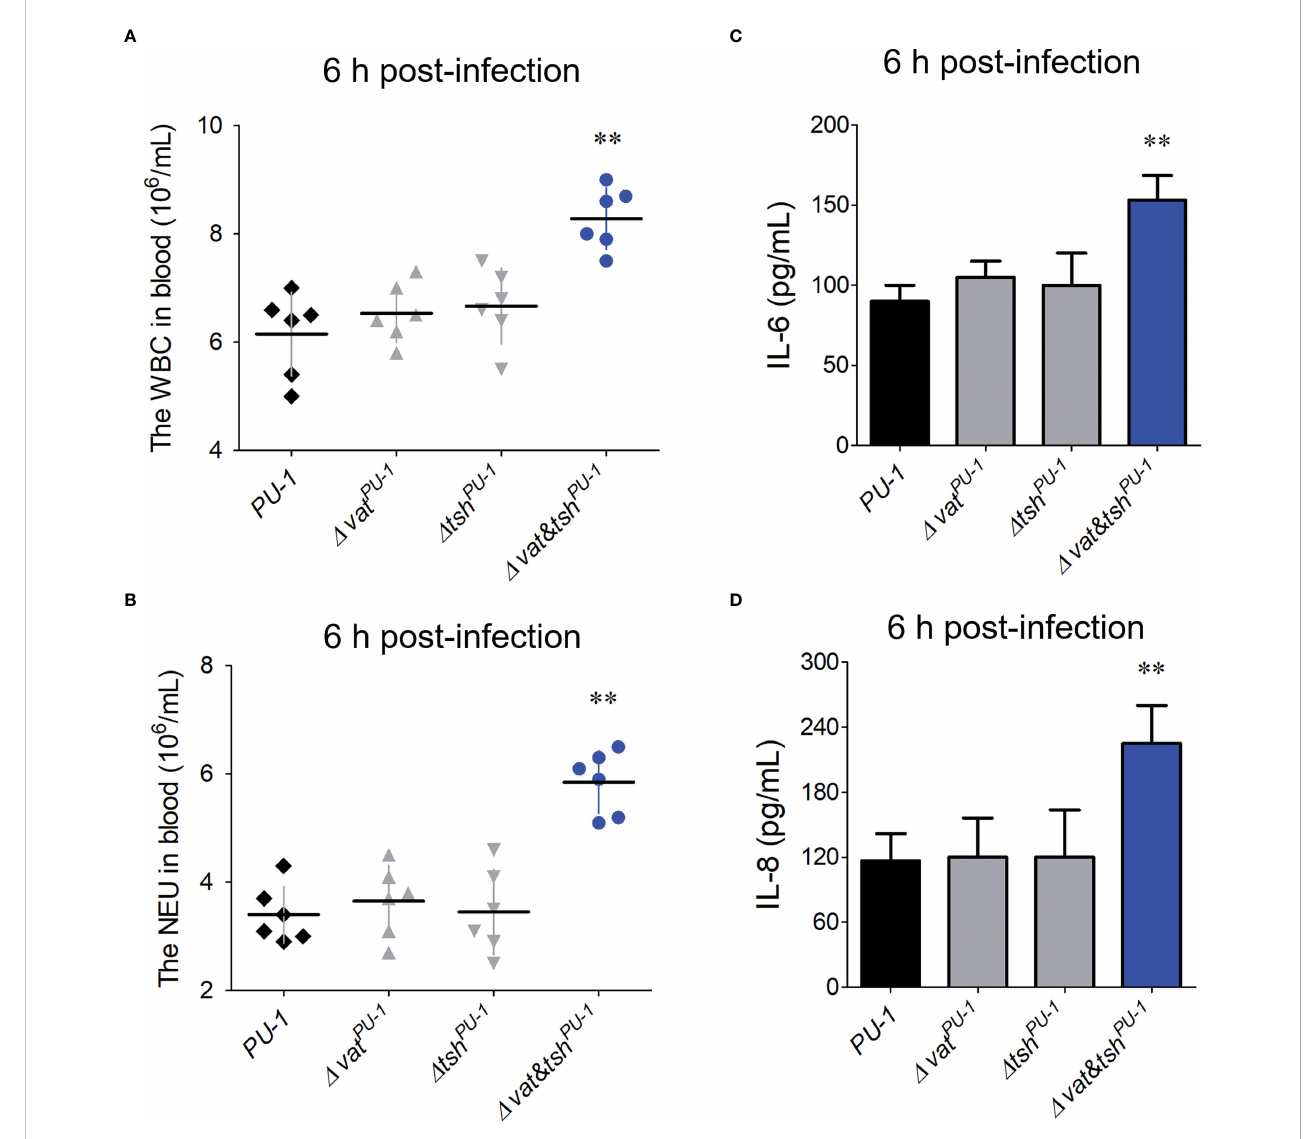
FIGURE 6 The assessment Vat PU-1 and Tsh PU-1 in modulation of host immune responses during blood infection. (A, B) Blood routine testing detected the white blood cell (WBC) and neutrophil cell (NEU) counts of peripheral blood from the mice infected with indicated ExPEC strains at the 6 h post-infection. (C, D) Detection of IL-6 and IL-8 levels in bloods from the mice infected with indicated ExPEC strains at the 6 h post-infection. Statistical signi fi cance was determined by a one-way ANOVA test based on comparisons with the wild-type group (**P <